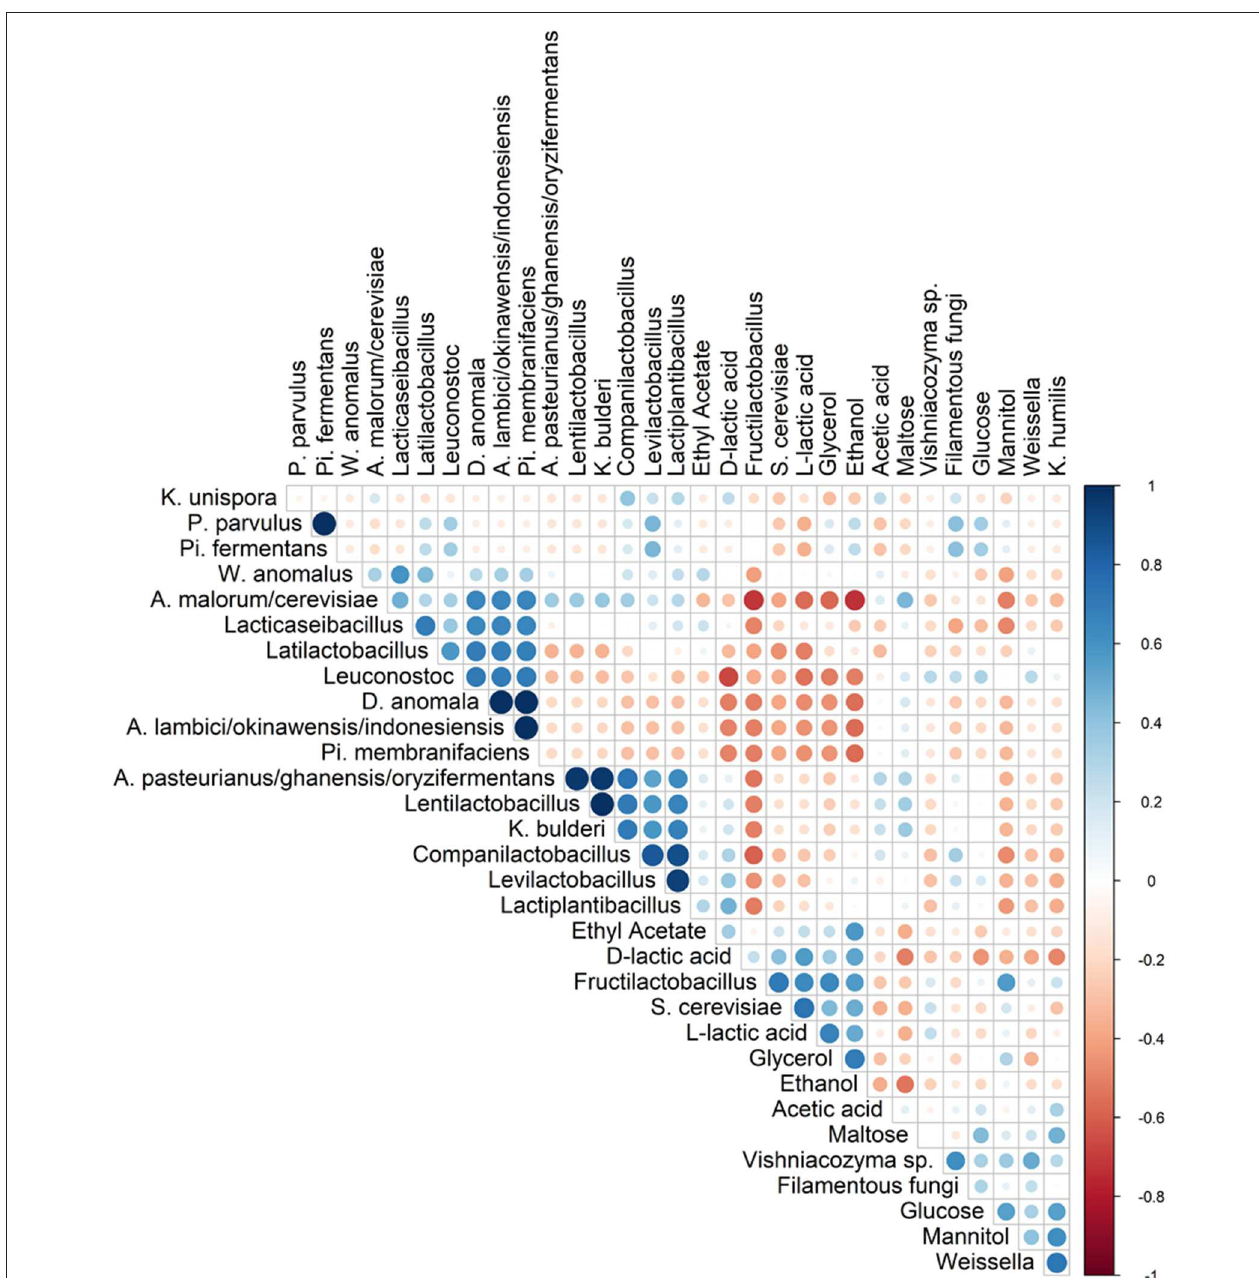
FIGURE 5 | Spearman correlation analysis between the different species (based on metagenetic analysis) and/or dedicated substrates consumed, and metabolites produced in 17 sourdough samples from backslopped sourdoughs of different origins. Positive and negative correlations are represented in blue and red, respectively. The size of the circle represents the numerical value of the correlation